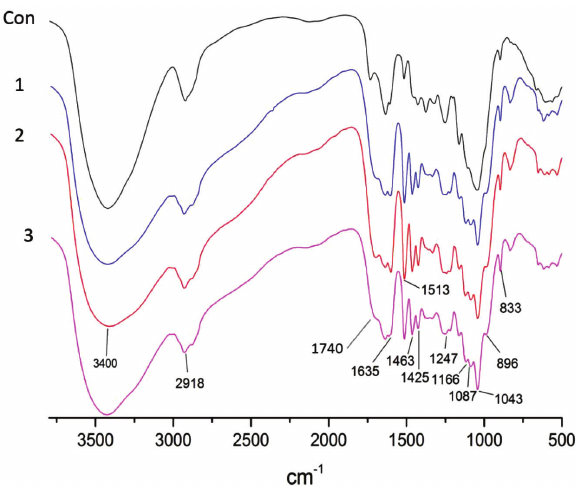
Fig. S3 – Enzymatic hydrolysis of cellulose from untreated corncob